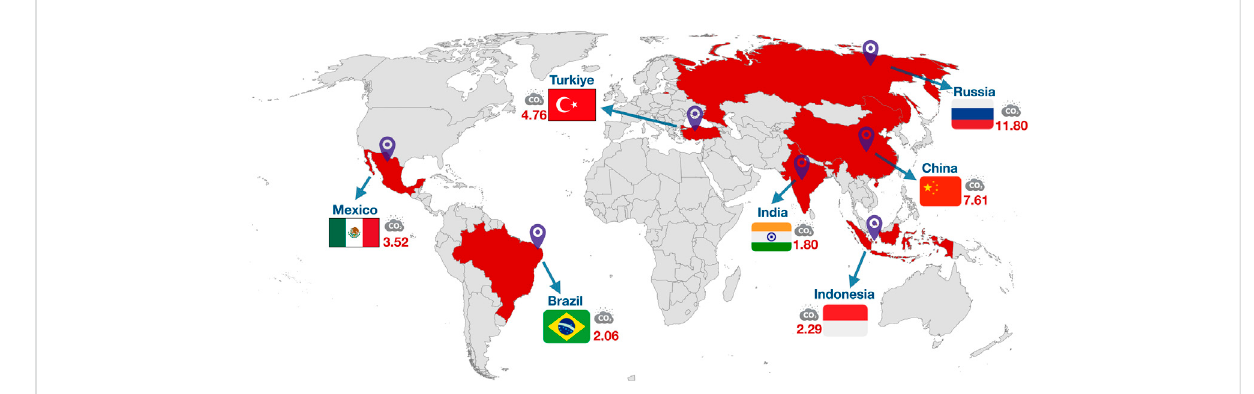
FIGURE 1 Trend of total CO 2 emissions in E-7 economies in million tons per capita in